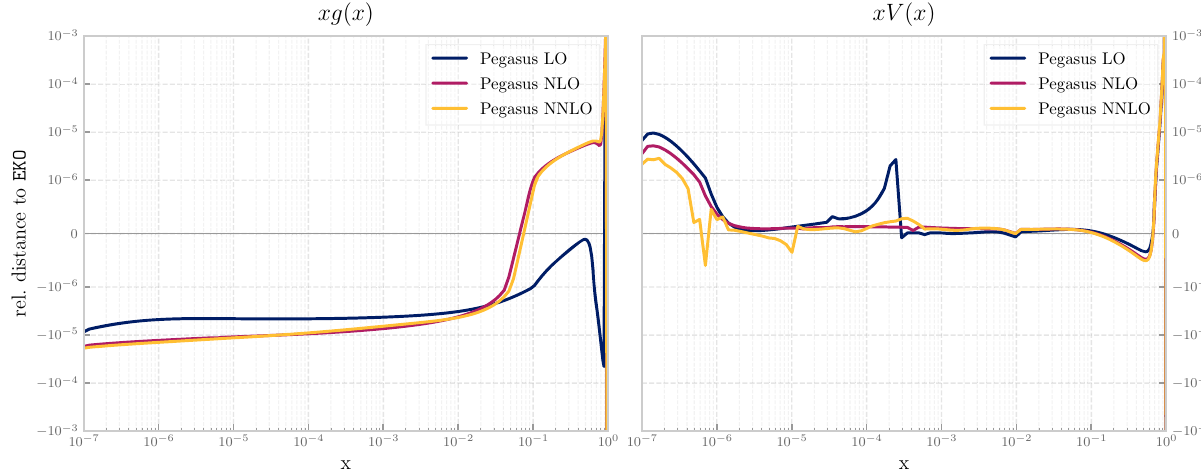
Fig. 3 Same of Fig. 2, now comparing to PEGASUS [27]